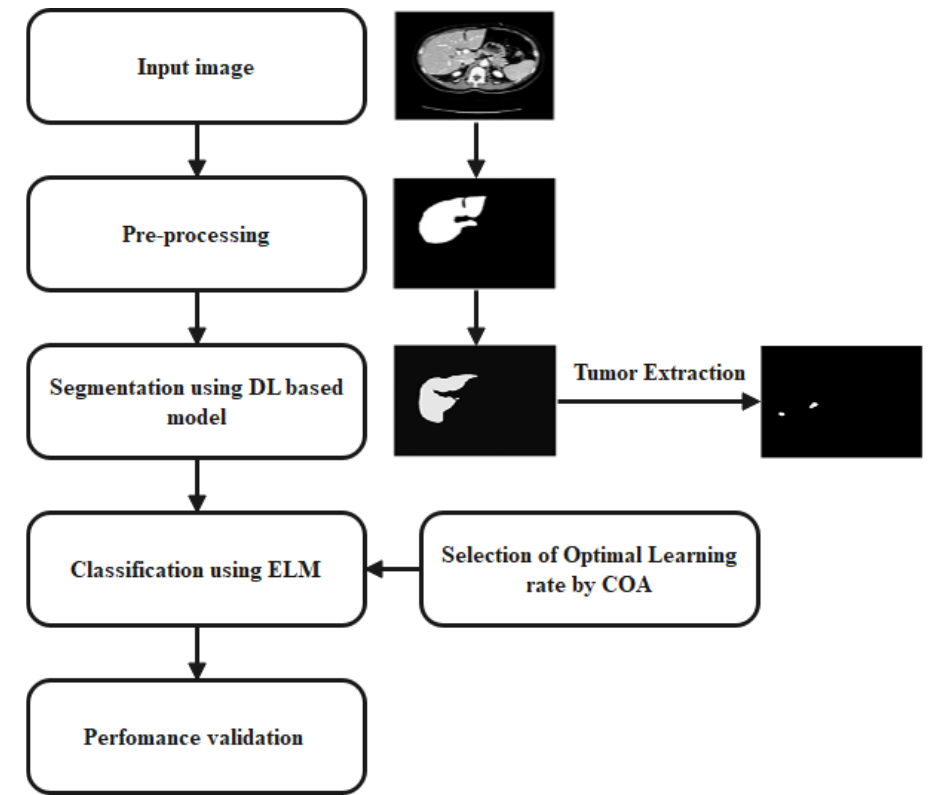
Figure 1. Working flow of the proposed model.